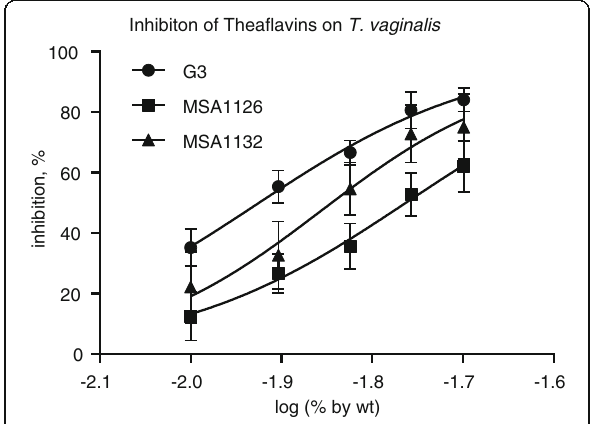
Fig. 4 Dose-dependent response of theaflavin-rich black tea extract on three different Trichomonas vaginalis isolates; genome strain G3, metronidazole-resistant strain MSA1126, and cytoadherent clinical strain